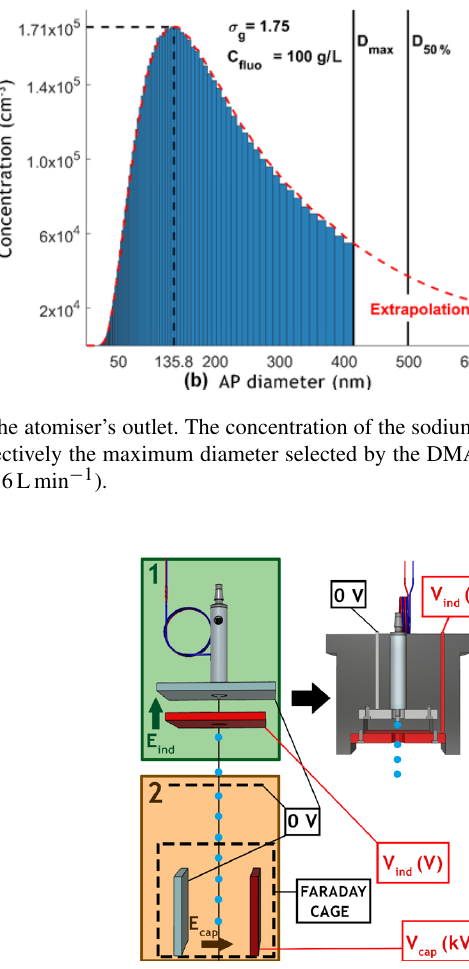
Figure 9. (Left) 1 – Electrostatic inductor set at the piezoelectric injector’s nozzle to electrically neutralise the droplets. 2 – Capacitor used to analyse the droplet deviation caused by the electric field in the capacitor ( E cap ). (Right) Housing made with a 3D printer containing the piezoelectric injector and the electrostatic inductor, set in the injection head (see Fig.